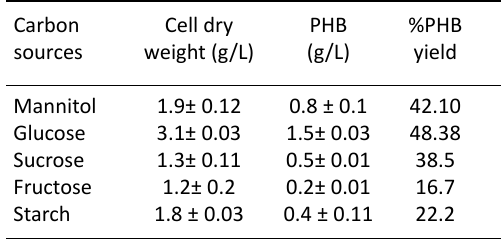
Table 8. Effect of different carbon source on production of PHB by Bacillus sp.